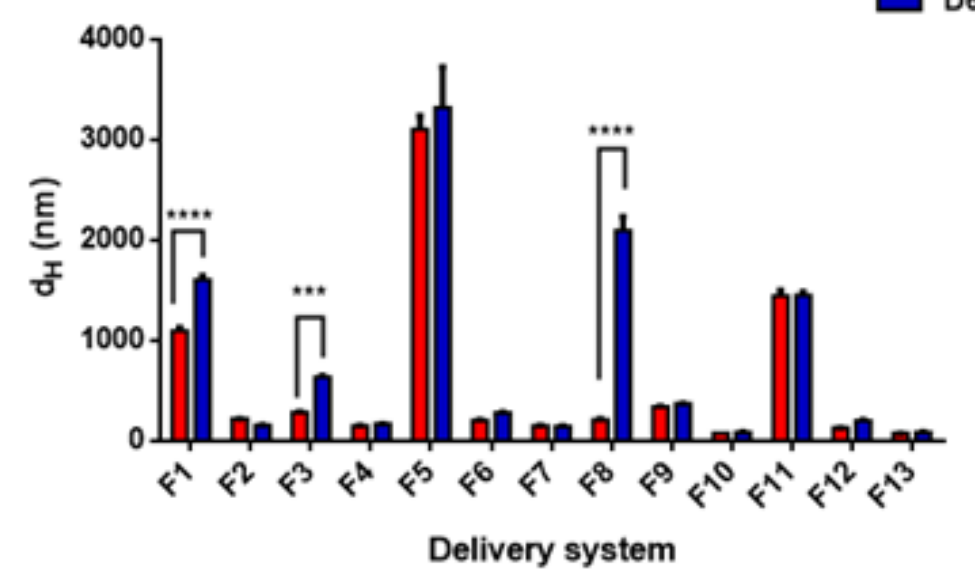
Figure 8. Effect of storage time on the stability of TC1 EO nanoemulsions (formulations F1–F9) and nanoparticles (formulations F10–F13). Statistical significance: *** p < 0.001 (very significant); **** p < 0.0001 (highly significant). Legend: day 0 (D0), day 60 (D60).